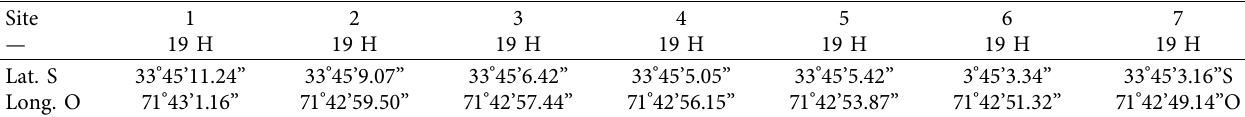
Figure 1: (a) Location of subsamples in Los Maitenes wetland. (b) Map showing the proximity to the industrial area. Table 1: Coordinates for extraction points of Sarcocornia neei , Yali